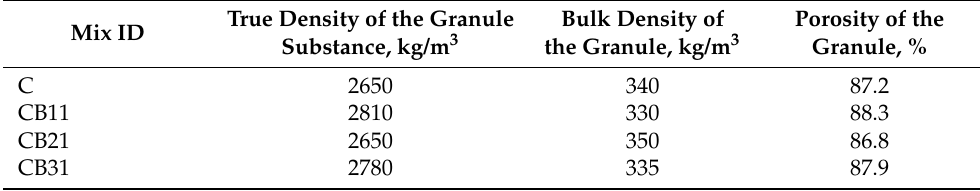
Table 3. Values of the total porosity of granules from raw mixtures of various compositions. True Density of the Granule Bulk Density of Porosity of the Mix ID Substance, kg/m 3 the Granule, kg/m 3 Granule, % C 2650 340 87.2 CB11 2810 330 88.3 CB21 2650 350 86.8 CB31 2780 335